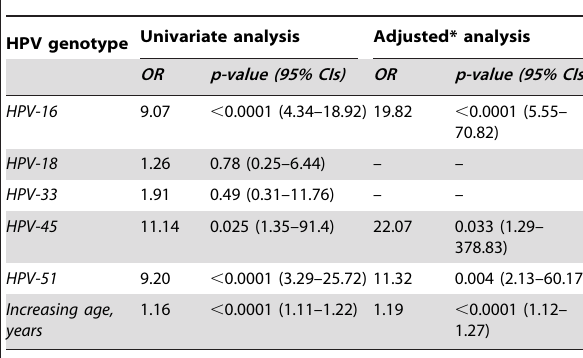
Table 2. Logistic regression analysis of the covariates associated with the invasive cervical